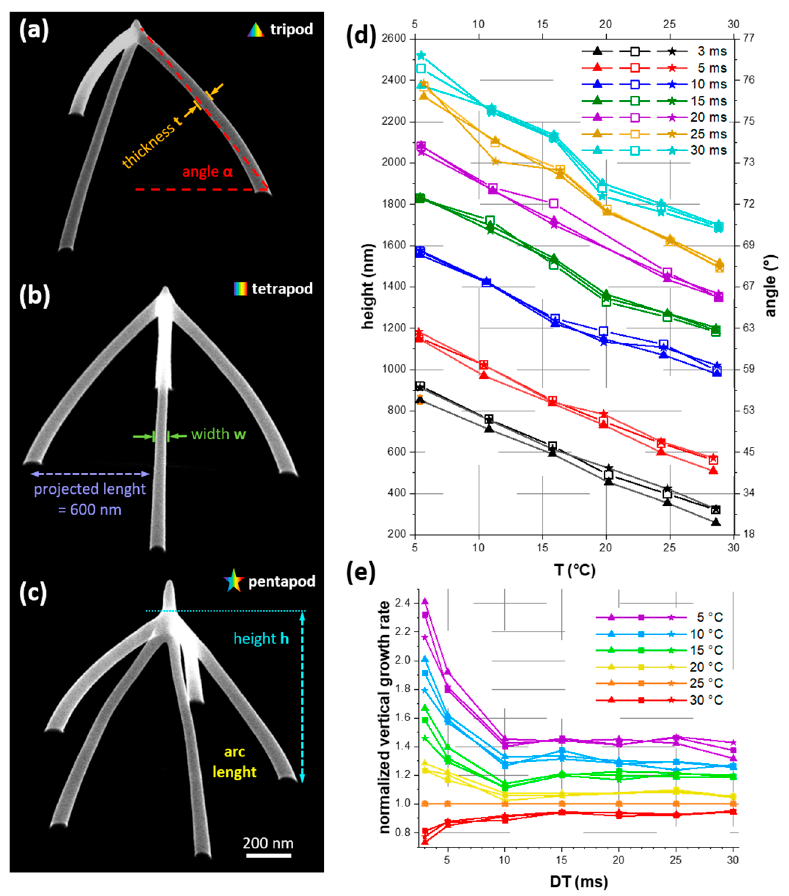
Figure 1. Measurements on 3D multipod nanostructures. SEM images of tripod ( a ), tetrapod ( b ) and pentapod ( c ) geometries, fabricated at 5 keV, 28 pA at constant dwell times of 3 ms and a T S of 5 ◦ C. ( d ) shows the total vertical heights h as a function of the T S for tri-, tetra- and pentapods (indicated as triangles, rectangles and stars, respectively) fabricated with different dwell times and a projected length of 600 nm. ( e ) Vertical growth rates normalized to a T S of 25 ◦